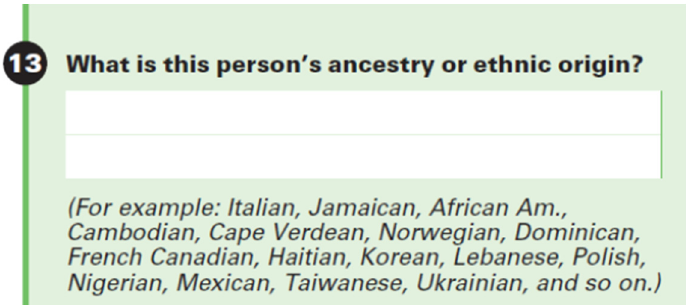
Figure 1. Ancestry question, as written in the 2021 American Community Survey.